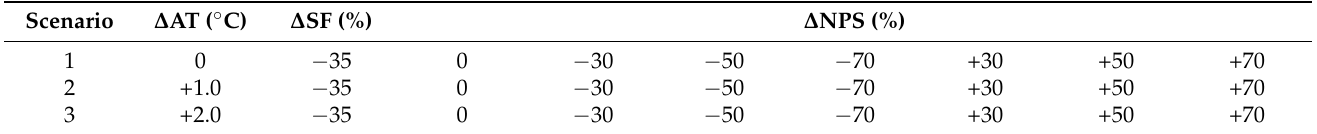
Table 5. Water quality improvement scenarios under climate change in the Shoalhaven River estuary by NPS discharge control.